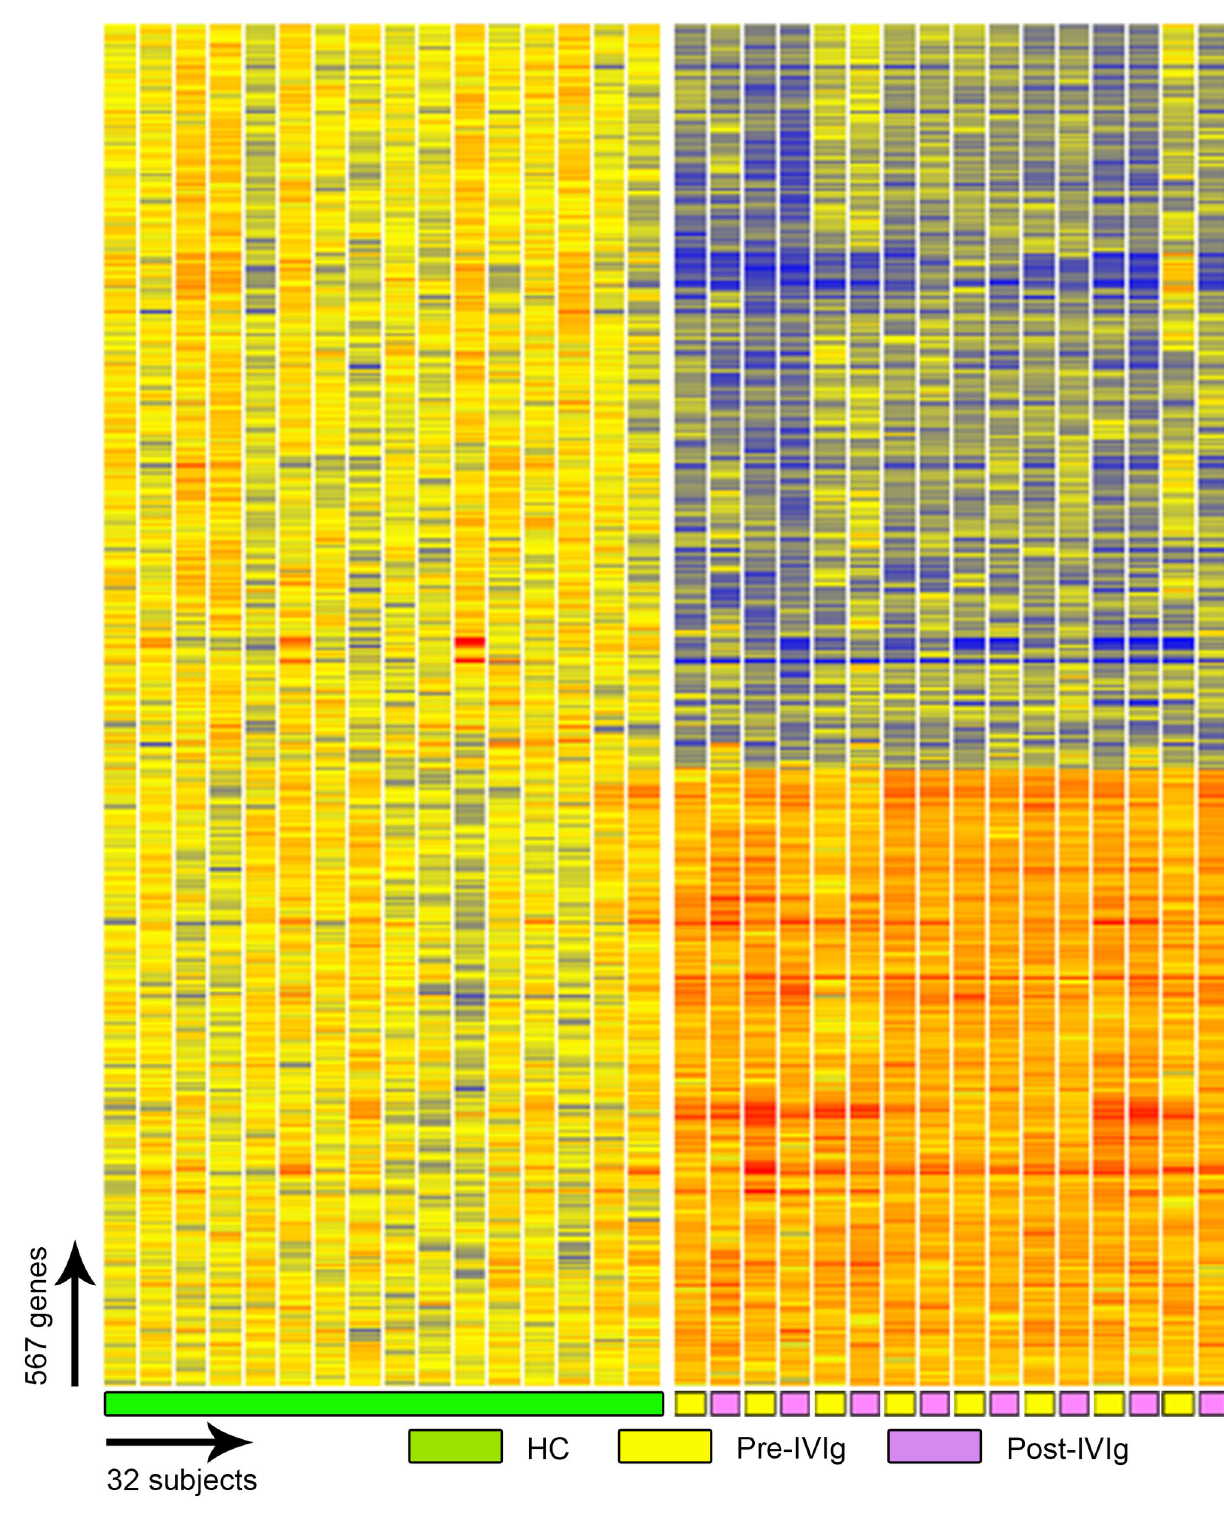
Figure 9. IVIg therapy and gene expression analysis. Eight additional CVID subjects were tested before and 5-7 days after receiving IVIg. Individual transcripts (567) were selected by Welch ANOVA test (MTC: Benjamini and Hochberg, FDR, p-cutoff <0.01) between healthy controls, pre-IVIg and post-IVIg patients.